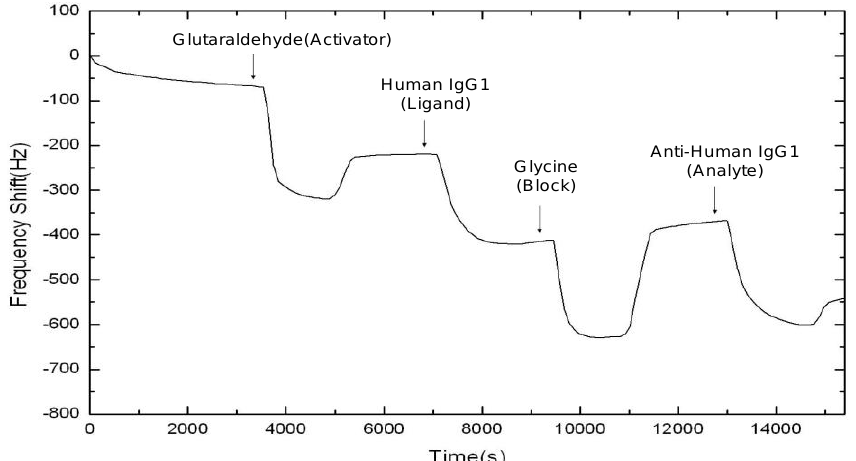
Figure 2. A typical result of the QCM experiment. There are four steps in the experimental process, as described in the text.